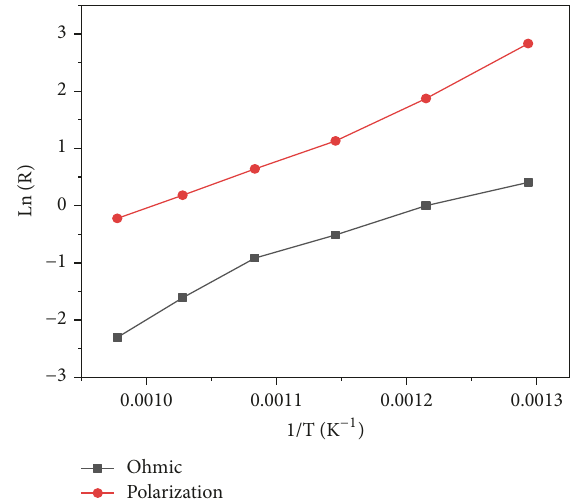
Figure 8: Logarithm of resistances as a function of the inverse